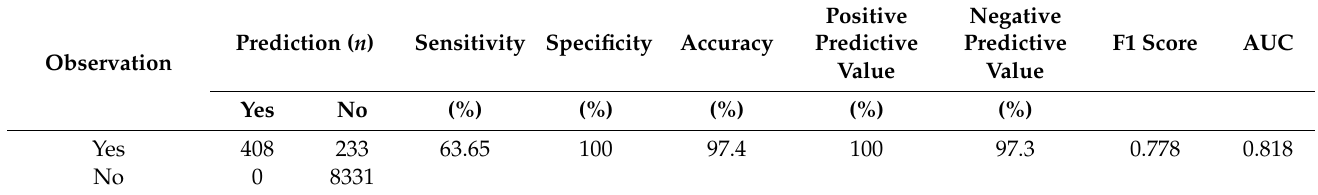
Table 3. Confusion matrix and prediction scores of random forest model with work-related